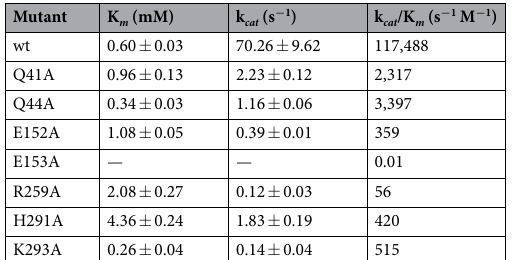
Table 1. Kinetic parameters for donor substrate CMP-Neu5Ac. Determined at constant acceptor concentration of 0.3 mg/mL colominic acid. Kinetic values are the mean ± s.e.m.